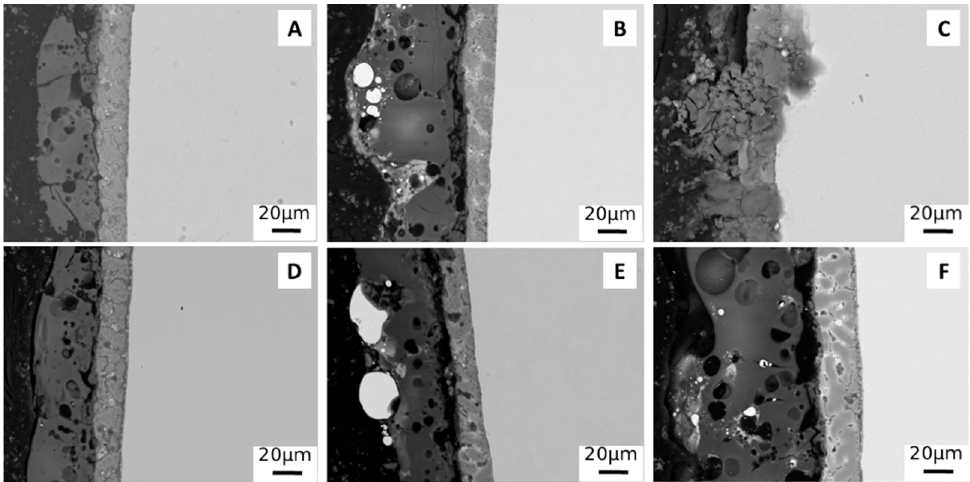
Figure 3. SEM images of the surfaces of PEO coatings obtained working at 0.5 A/cm 2 in DC mode without particles ( A ), with large particles ( B ) and with small particles ( C ), and working at 1 A/cm 2 in UPC without particles ( D ), with large particles ( E ) and with small particles ( F ).